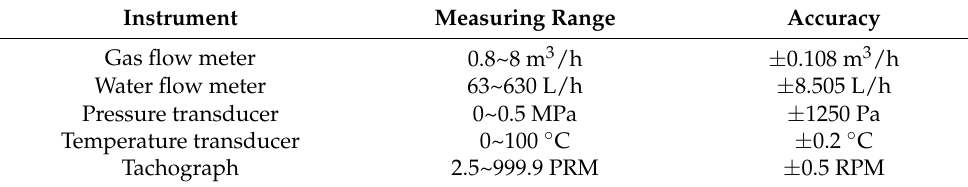
Table 2. Measured ranges and accuracy of the instruments in the experimental equipment.